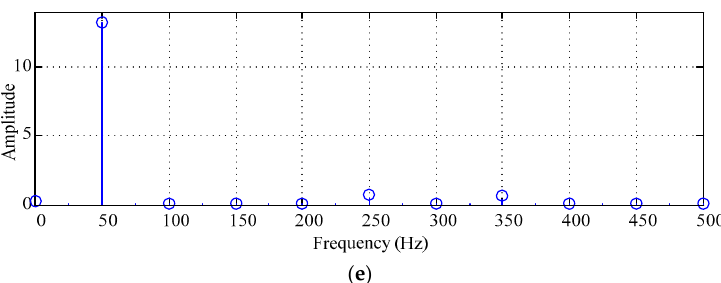
Figure 11. The performance of generator and harmonic analysis under normal operation. ( a ) Rotor floating waveform in x axis; ( b ) Rotor floating waveform in y axis; ( c ) The output voltage effective value; ( d ) The generation winding induced current; ( e ) Winding current harmonic under the rated load.